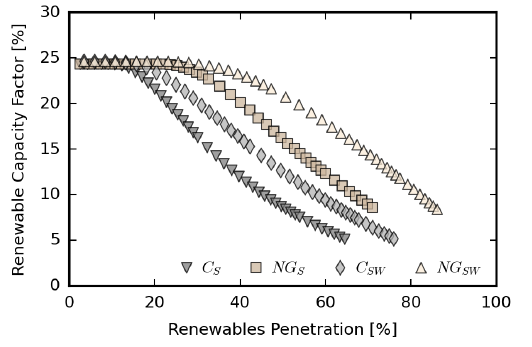
Figure 11. Capacity factor for the studied cases, including possible curtailment at higher renewable